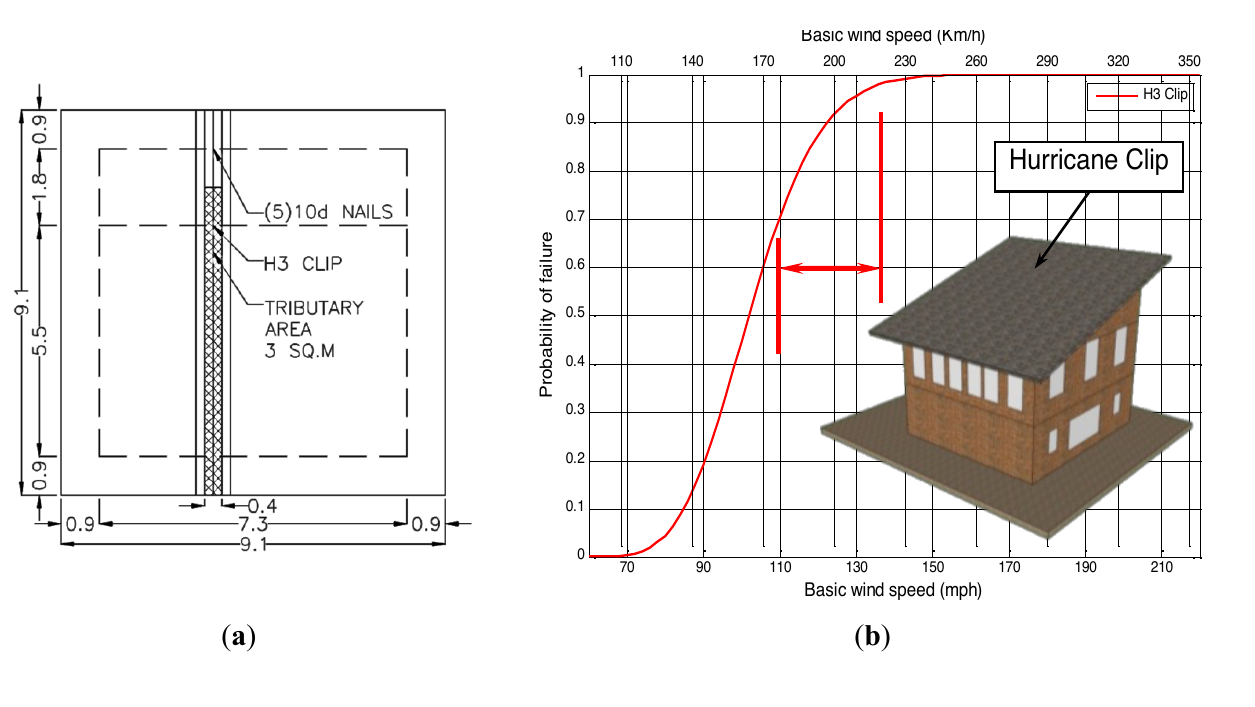
Figure 10. ( a ) Loading condition considered for the fragility analysis; ( b ) Fragility for H3 hurricane clip when nail connection has